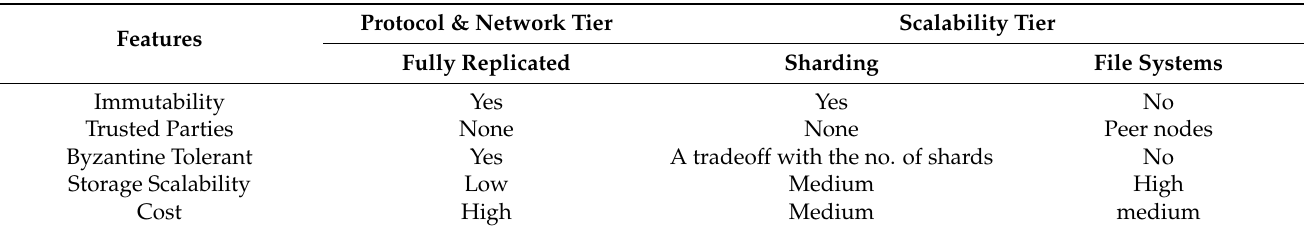
Table 6. Scalability tier storage